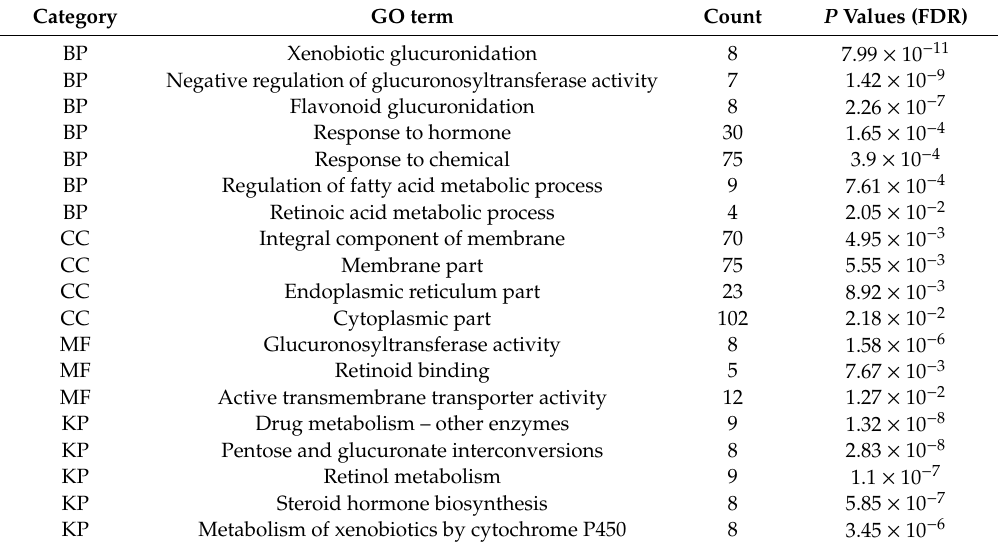
Table 1. Overrepresentation of enriched Gene Ontology (GO) terms within genes co-segregating with